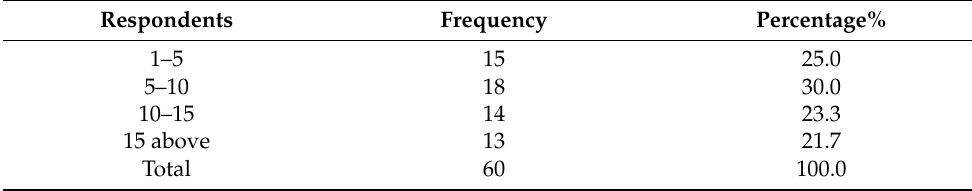
Table 8. Operation years in the company.